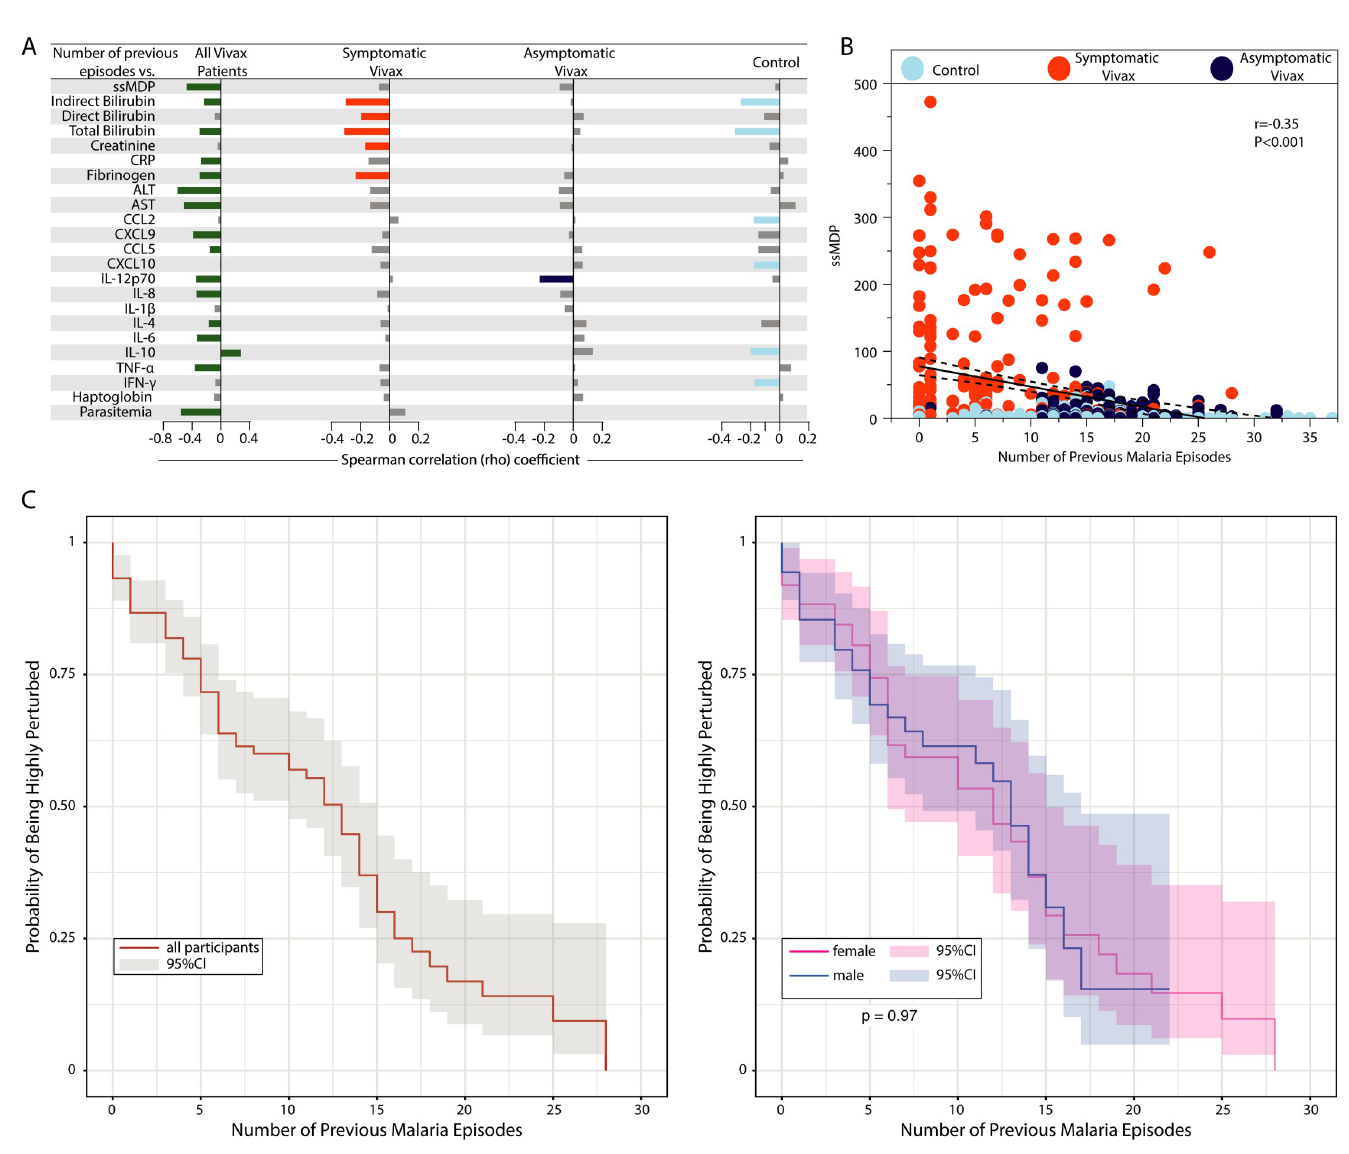
Fig 4. Heightened number of previous malaria episodes mitigates the inflammatory imbalance in the current Plasmodium vivax infection. (A) Spearman correlation between the number of previous malaria episodes and the global degree of inflammatory perturbation (ssMDP) of each parameter’s individual MDP values. Bars represent the Spearman rank coefficient value (rho). Colored bars (each clinical group is represented by a different color) infer correlations that presented adjusted P-value < 0.05. (B) A scatter plot was employed to show the correlation between the number of previous malaria episodes and the ssMDP score values. (C) Probability of being highly perturbed ( > 2 standard deviations from control group) according to the number of previous malaria episodes in all participants (left panel) and participants grouped based on biological sex. The curves were compared using the Steger Method. Abbreviations (alphabetic order): ALT: alanine aminotransferase; AST: